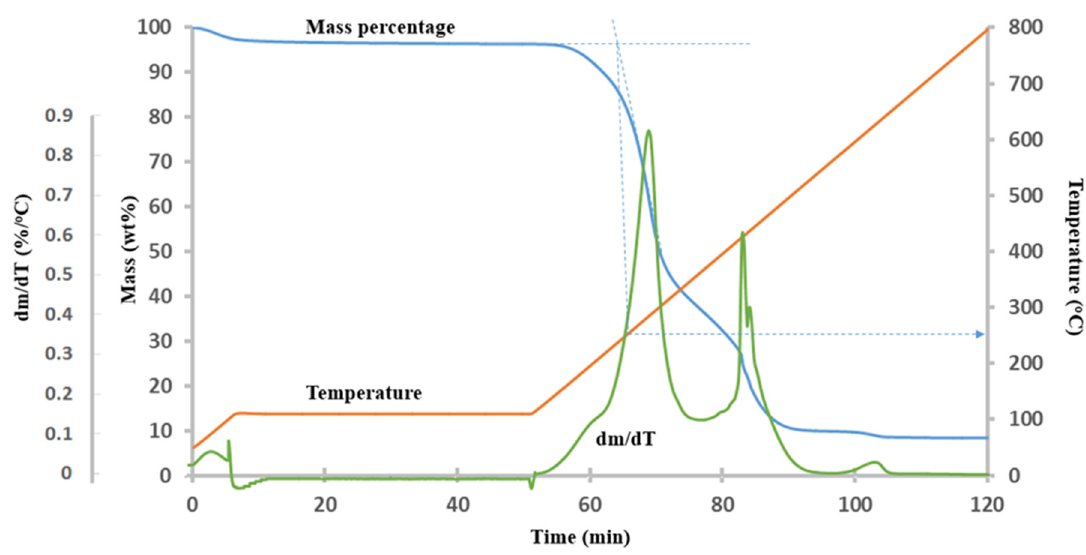
Figure 6. Thermogravimetric analysis of a canola hull pellet.